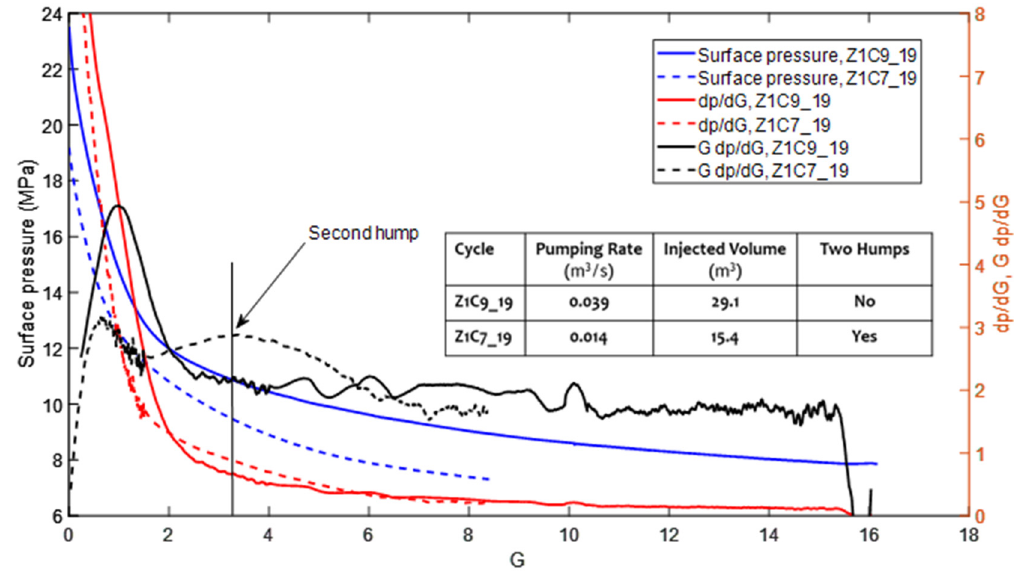
Figure 16. Comparison of the G-function between Zone 1 Cycle 7 and Zone 1 Cycle 9 during the 2019 injection program. There were two humps in GdP / dG in Zone 1 Cycle 7, 2019, while no such feature is seen in Zone 1 Cycle 9, 2019.